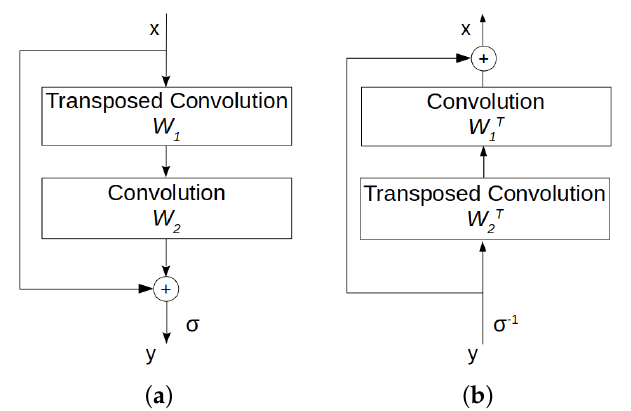
Figure 3. ( a ) Residual block. ( b ) Inverted residual